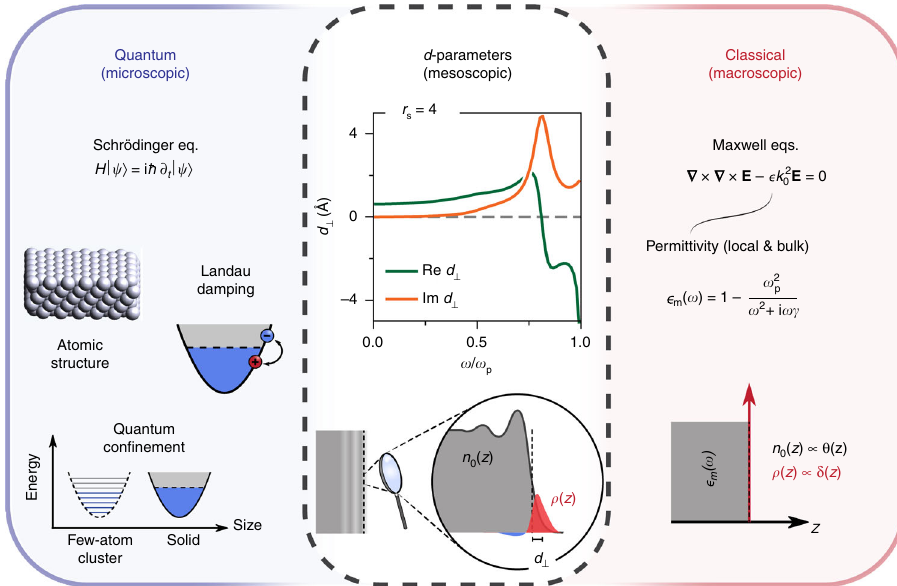
Fig. 1 Nonclassical mesoscopic electrodynamics via d -parameters. The nonclassical surface-response functions — the Feibelman d -parameters — rigorously incorporate quantum mechanical effects in mesoscopic electrodynamics, bridging the gap between the purely quantum (microscopic) and classical (macroscopic) domains. Inset: d -parameter of an r s ¼ 4 jellium computed from TDDFT 17 ; the corresponding d ? neutrality 33